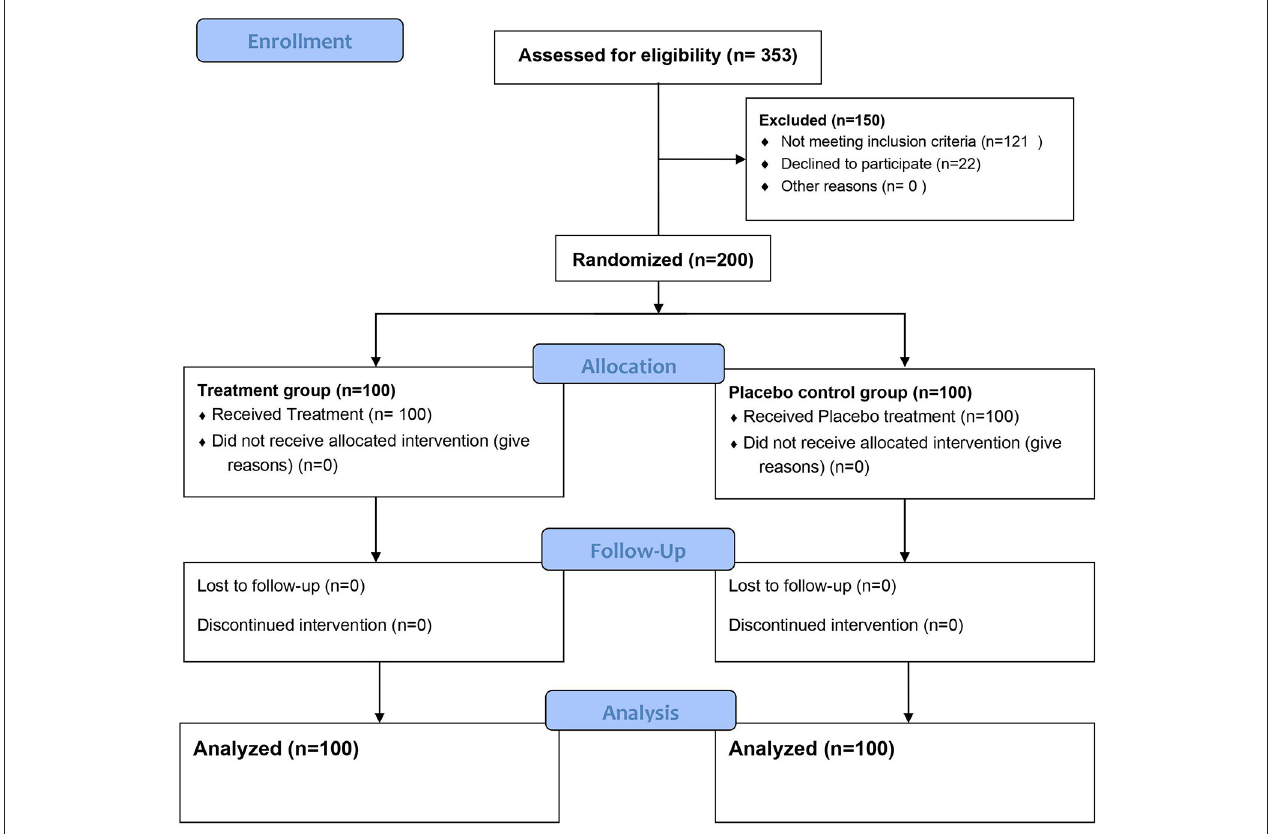
FIGURE 1 | Consort study